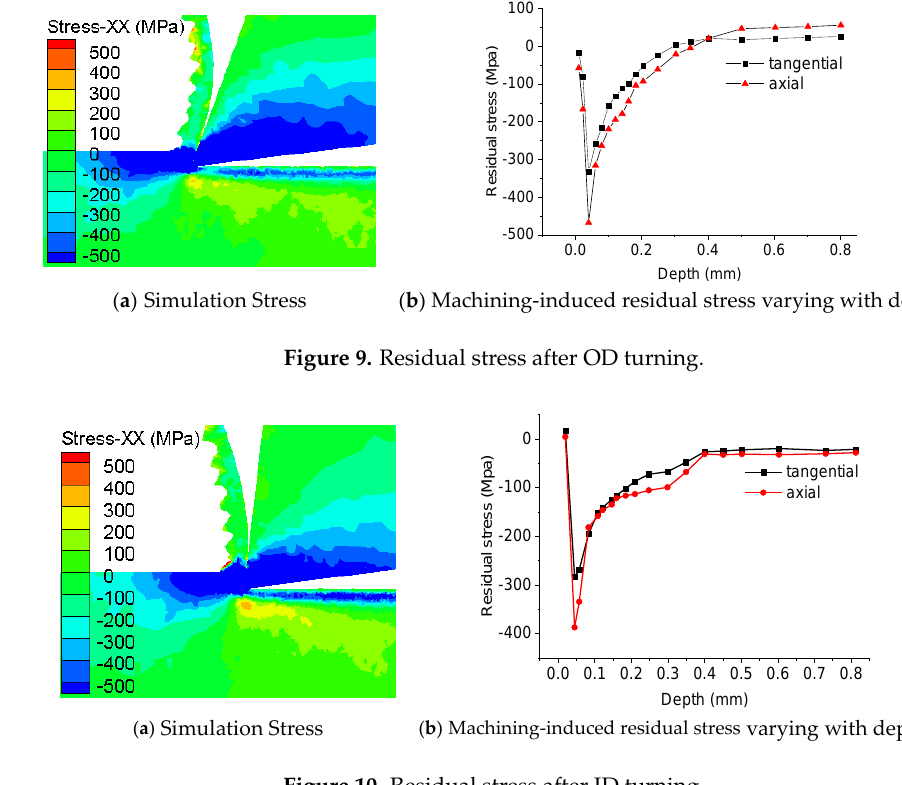
Figure 10. Residual stress after ID turning.